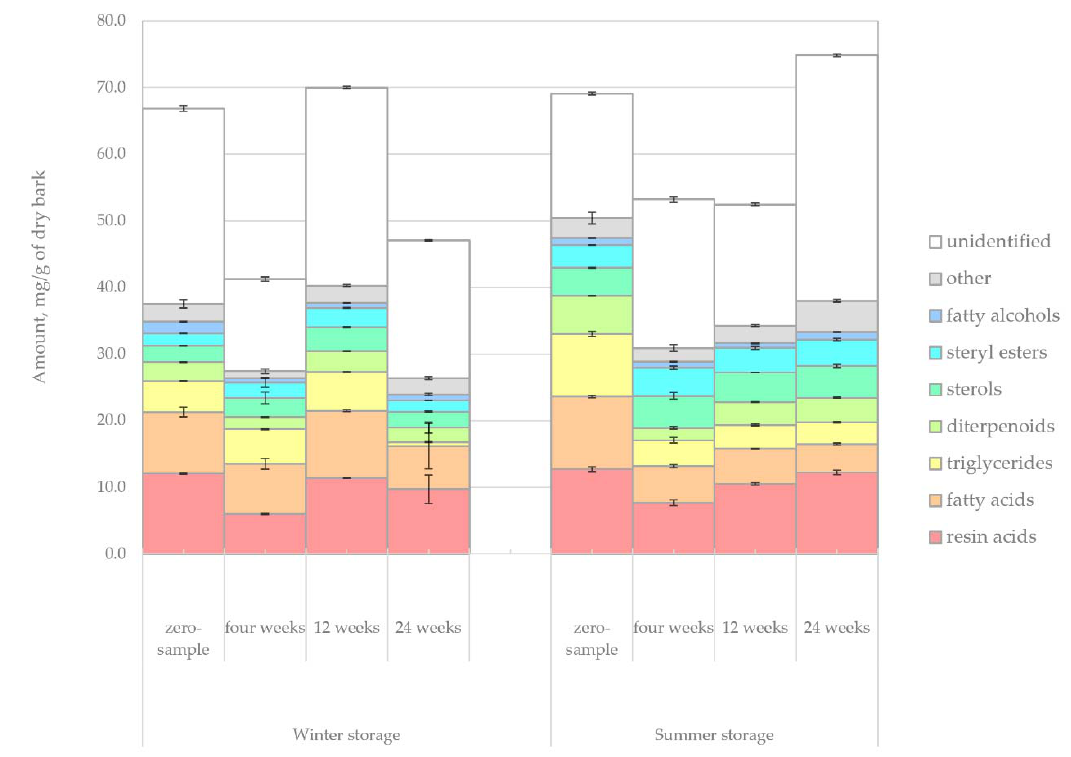
Figure 4. Changes in the amount of lipophilic compounds (mg/g of dry matter) in saw log bark during summer and winter storage periods. Results presented here are a combination of the quantified long-column gas chromatography with a flame ionisation detector (GC-FID) individual free and esterified compounds and the short-column GC-FID extractives groups (triglycerides and steryl esters).